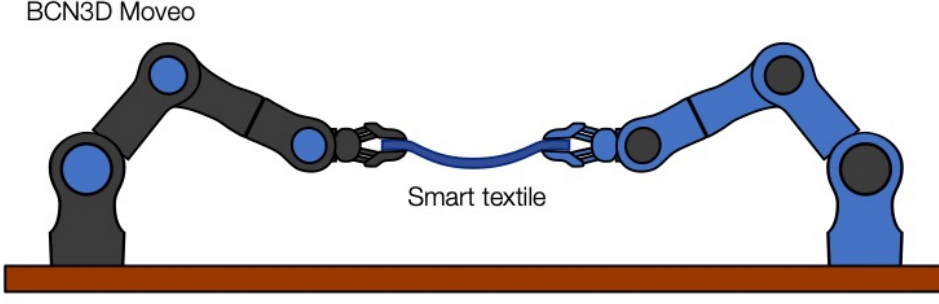
Figure 1. Schematic overview of the setup: dual robot arms hold a smart textile piece and have to learn to fold it from scratch using sensory feedback of the textile and proprioceptive input of the robotic